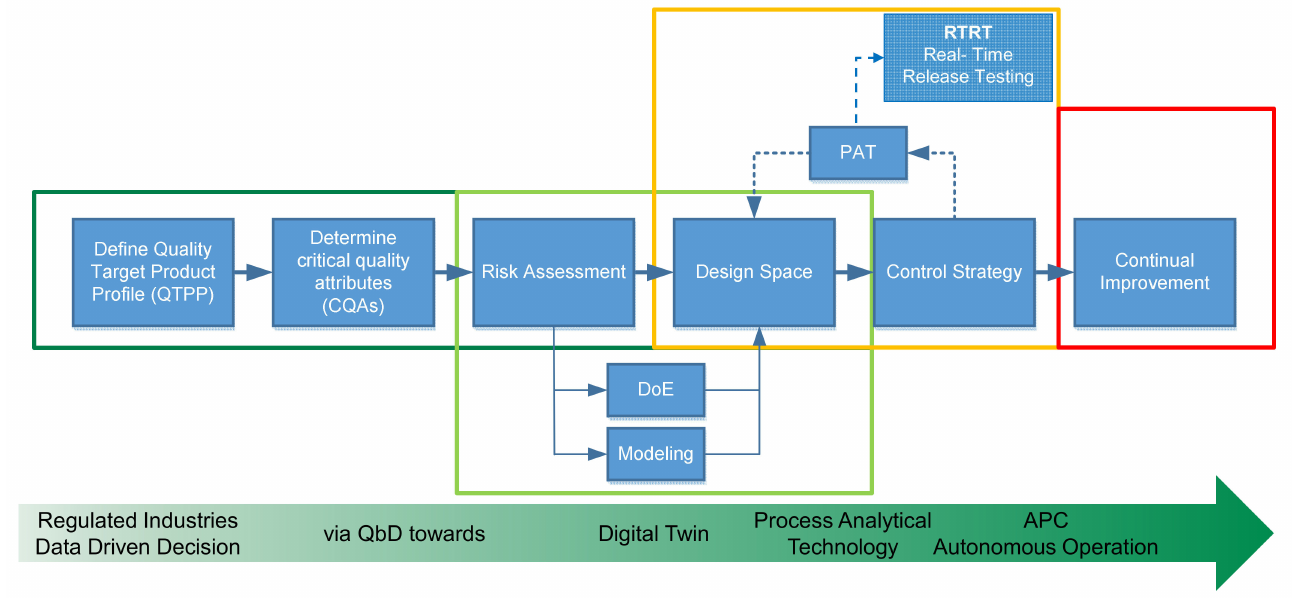
Figure 1. Overview of QbD and PAT concept and implementation, extended from